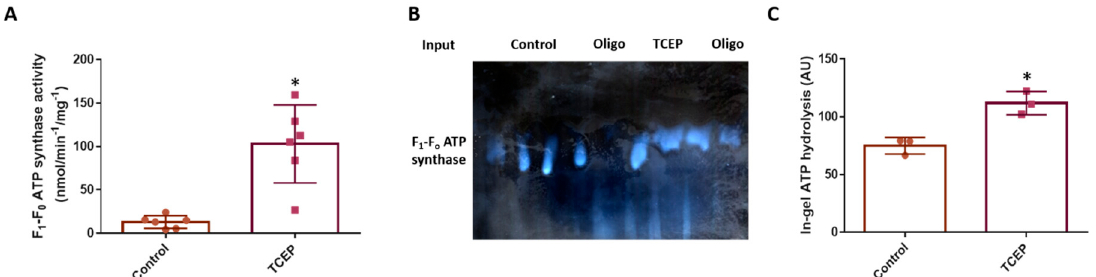
Figure 5. Reversible thiol oxidation inhibits the F 1 -F o ATP synthase. ( A ). Chemically reversing